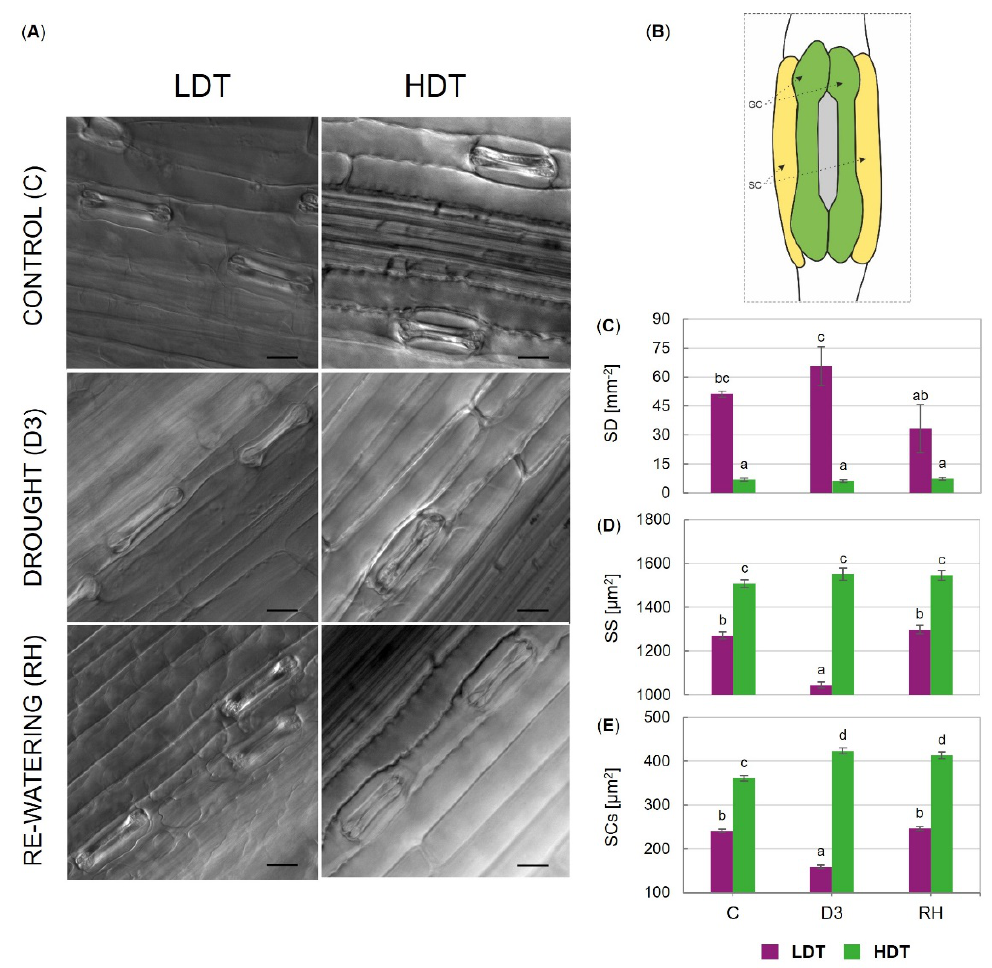
Figure 2. ( A ) Light micrographs illustrating leaf surfaces and stomata of two L. multiflorum / F. arundinacea introgression forms (low- and high-drought tolerant—LDT and HDT, respectively) before stress treatment (C), on the 10th (D3) day of the water deficit, and 10 days after re-watering (RH), scale bars 20 µ m. ( B ) Schematic of the dumbbell-shaped guard cells (GC) and flanking subsidiary cells (SC) surrounding the stomatal pore. ( C ) Stomatal density (SD), ( D ) stomatal size (SS), and ( E ) subsidiary cells size (SCs) in the LDT and HDT forms at C, D3, and RH. Error bars represent the standard errors. Homogeneous groups are denoted by the same letter according to Fisher’s LSD test ( p = 0.01).